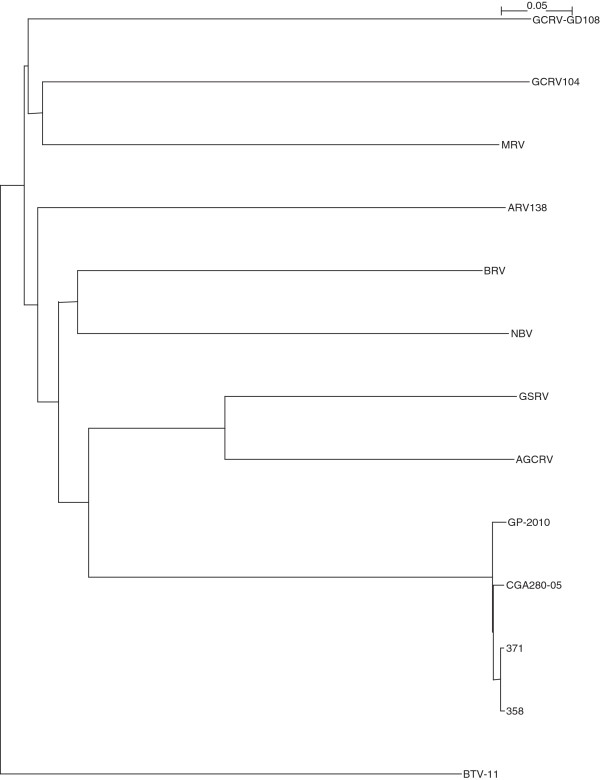
Phylogeny of homologous segment S3 shared by piscine reovirus (PRV) and selected members of familyReoviridae.